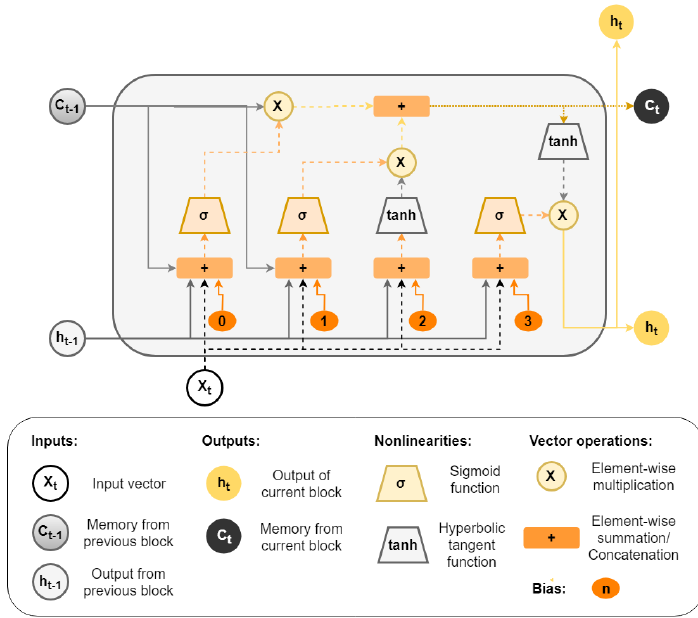
Figure 2. Example of an LSTM